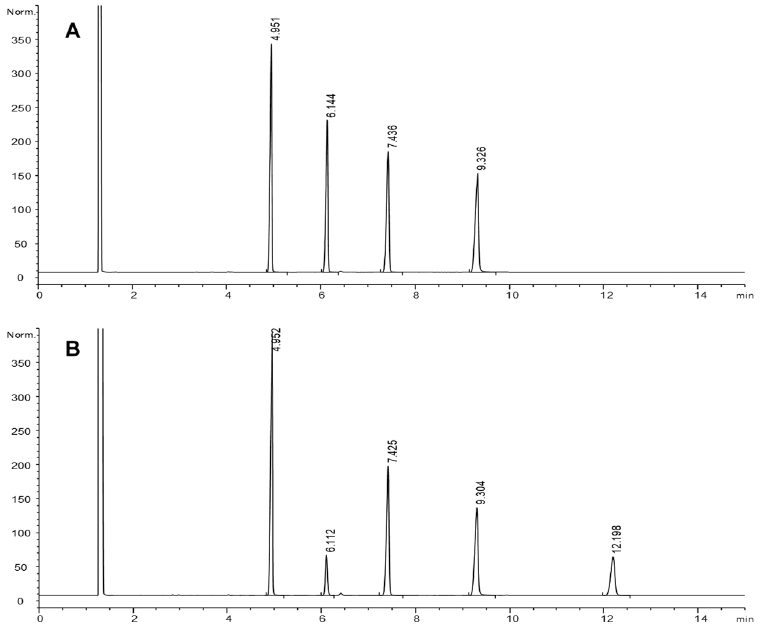
Figure 1. GC ‐ FID chromatograms of a sample of the 9,10 ‐ epoxystearate, 12 ‐ oxostearate and 12 ‐ hydroxystearate equimolar mixture before ( A ) and after ( B ) simulated gastric digestion of 1 mL sample volume. Retention times (min): 4.9, methyl heneicosanoate (IS); 6.1, methyl 9,10 ‐ epoxystearate; 7.4, methyl 12 ‐ oxostearate; 9.3, methyl 12 ‐ hydroxystearate; 12.2, methyl 9,10 ‐ dihydroxystearate. Chromatographic conditions: J&W DB ‐ Wax column; 230 °C.